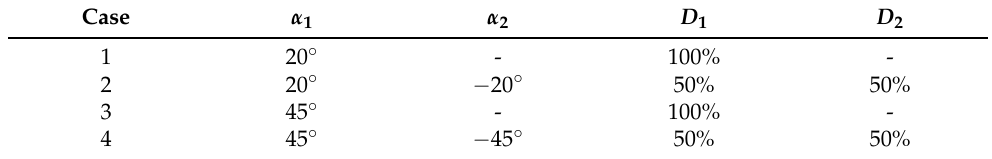
Table 3. Table summarizing the geometry parameters for the experimental validation tests